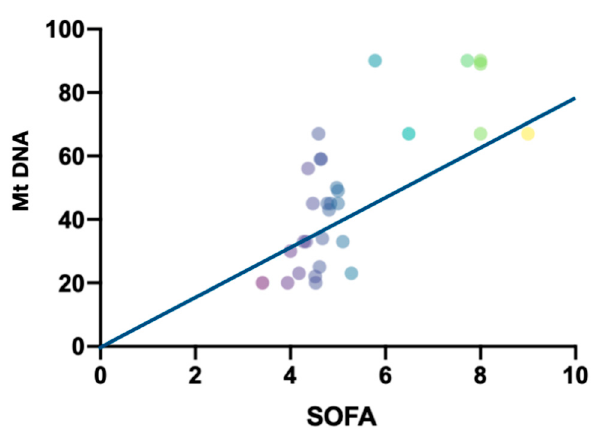
Figure 6. Regression analysis between the indicators of the severity of MOF according to SOFA score and the level of plasma mtDNA in patients (r = 0.45 and p = 0.028).